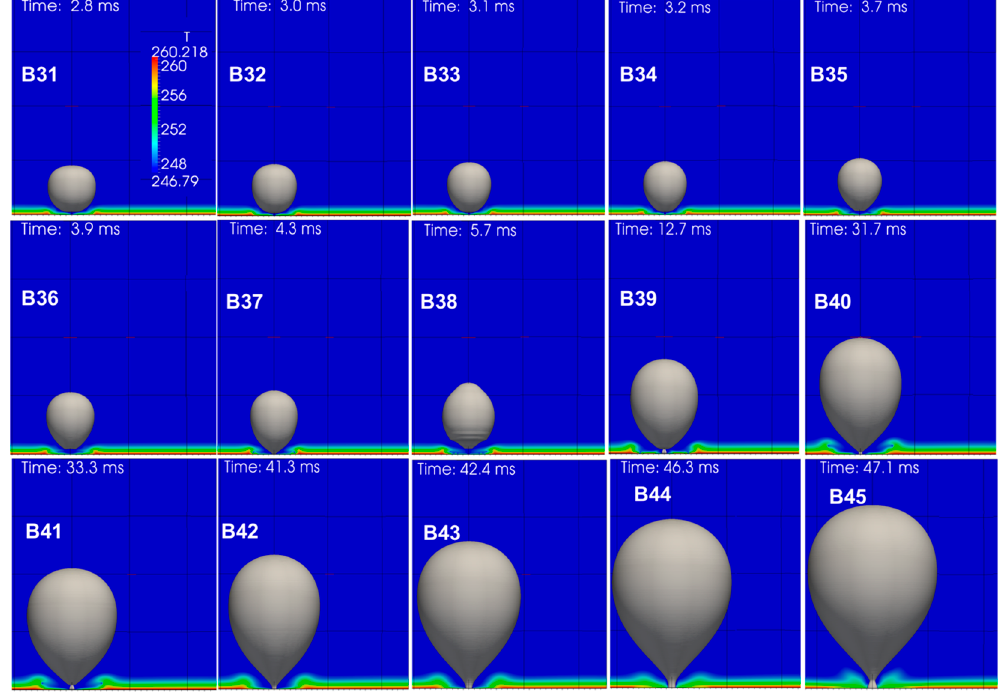
Figure 16. Spatial evolution of generated bubble at the time of detachment for each R134a case of the Series B parametric numerical simulations.